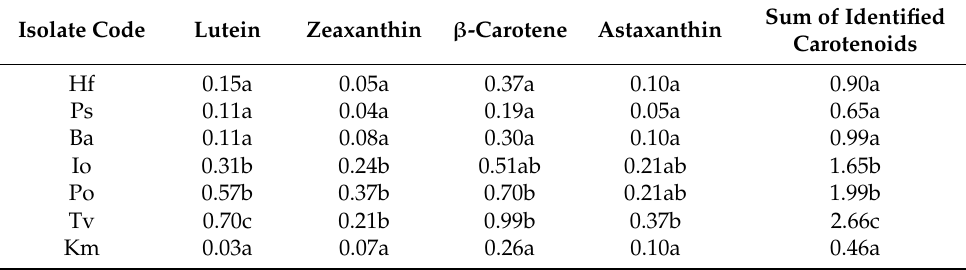
Table 5. The carotenoids concentration (mg/kg) in 7 fungal isolates.